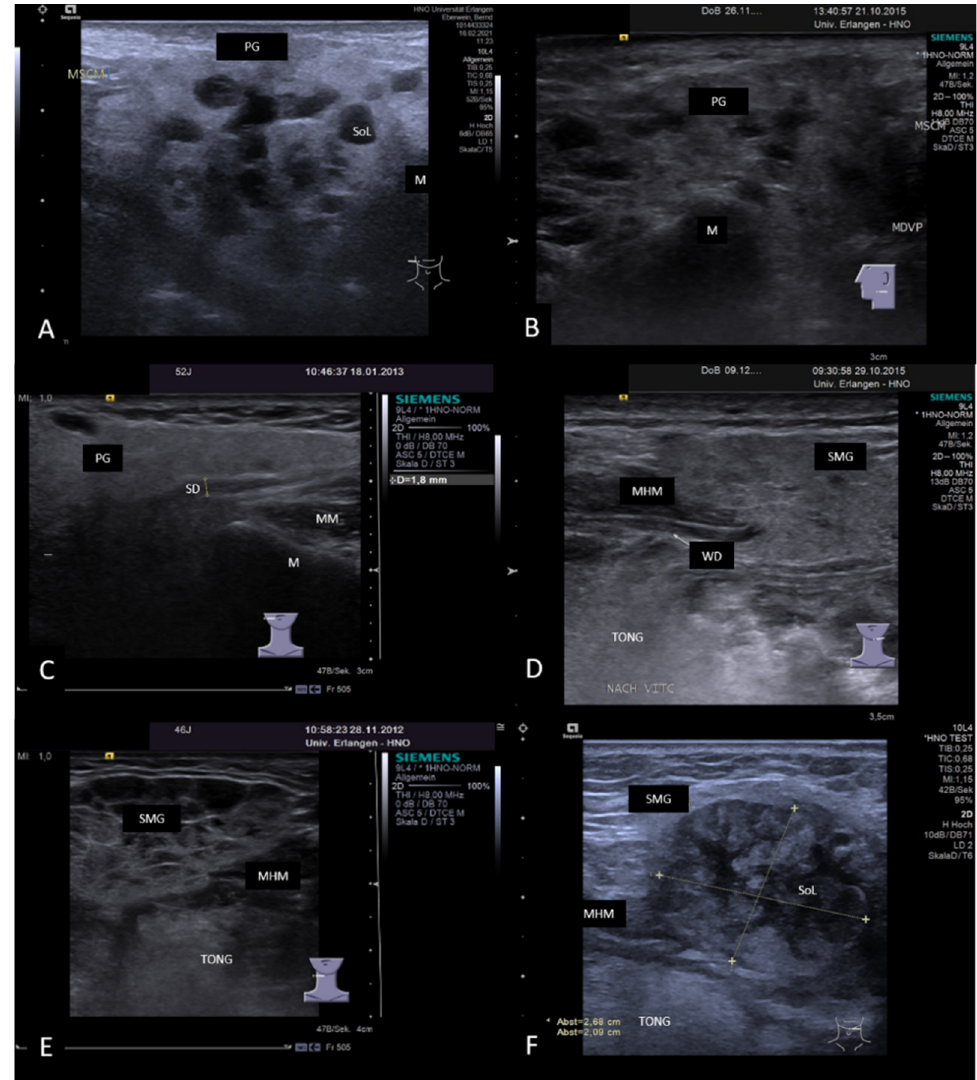
Figure 16. ( A – E ): Ultrasound images in histology-proven IgG-4-related salivary gland disease show- ing the variability of the findings in PGs and SMGs. In Figures ( A , B ), the parenchyma of PGs of the left side shows multiple hypoechoic to anechoic space-occupying lesions, while the residual gland parenchyma itself was not significantly changed ( A ) or hypoechoic ( B ). These presumably mainly represent an infiltration of lymphatic cells. The gland parenchyma of the PG in Figure ( C ) has a fine granulated tissue texture with a slightly dilated duct (measuring 1.8 mm, C ) similar to ( D ), where a SMG on the left side is depicted. In this gland, the diffuse changes appear more pronounced. In both cases, the glands are not significantly enlarged. ( E ) shows an enlarged SMG on the right side. The parenchyma is characterized by hypoechoic honeycomb-like changes due to the infiltration of the cells of the lymphatic system. As Figure ( F ) illustrates, tissue changes may also look like a tumor: a heterogeneous, irregular shaped, but sharply outlined space-occupying lesion measuring 2.68 × 2.09 cm is visible. Histologic finding after submandibulectomy revealed an IgG4-associated xanthogran- ulomatous sialadenitis (>150 positive cells per 1 HPF) with prominent histiocytic reaction. Note that the gland tissue surrounding the lesion does not appear pathologically changed. Abbreviations: PG, parotid gland; SMG, submandibular gland; M, mandible; MM, masseter muscle; MHM, mylohyoid muscle; MDVP, digastric muscle venter posterior; MSCM, sternocleidomastoid muscle; TONG, tongue; SD, Stensen ’ s duct; WD, Wharton’s duct; SoL, space occupying lesion. As clinical symptoms are often unspecific, a distinct proportion of the patients pre- sent with a hard nodule in the submandibular space. In these cases, ultrasound shows changes in the submandibular gland characteristic for chronic fibrotic sialadenitis. The